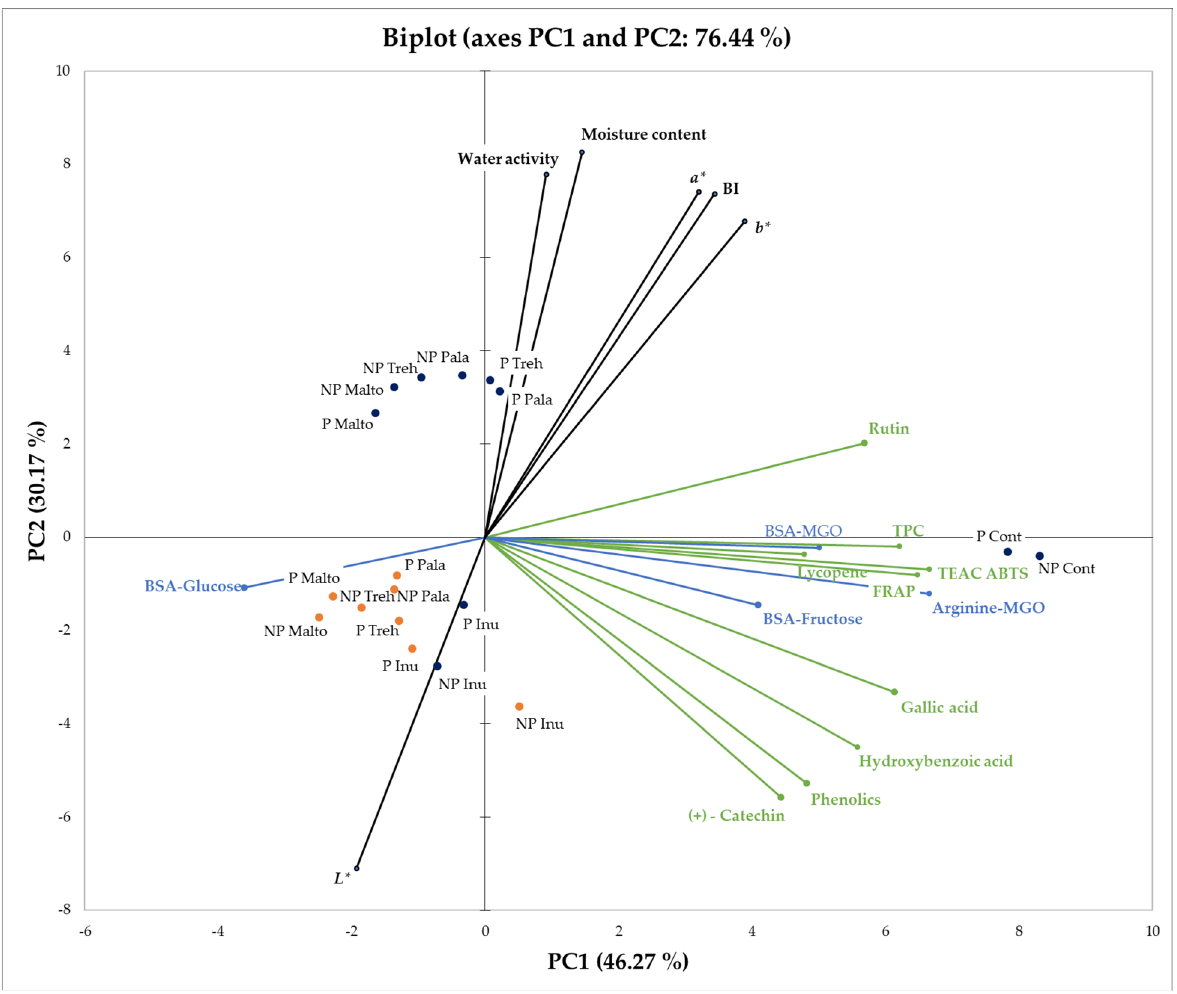
Figure 1. Principal Component Analysis (PCA) biplot of the first two principal components for the rosehip juice powders. PCA indicates how pasteurization of rosehip juice, drying technique (freeze- and spray drying) and application of carrier (no carrier (control), maltodextrin, inulin, trehalose, palatinose) relate to each other; P—pasteurized juice, NP—non-pasteurized juice, Cont—control, Malto—maltodextrin, Inu—inulin, Treh—trehalose, Pala—palatinose, BI—browning index, TPC— Total Phenolics Content, TEAC ABTS—Trolox Equivalent Antioxidant Capacity by ABTS assay, FRAP—Ferric Reducing Antioxidant Potential, FD—freeze-drying marked as navy blue dots, SD—